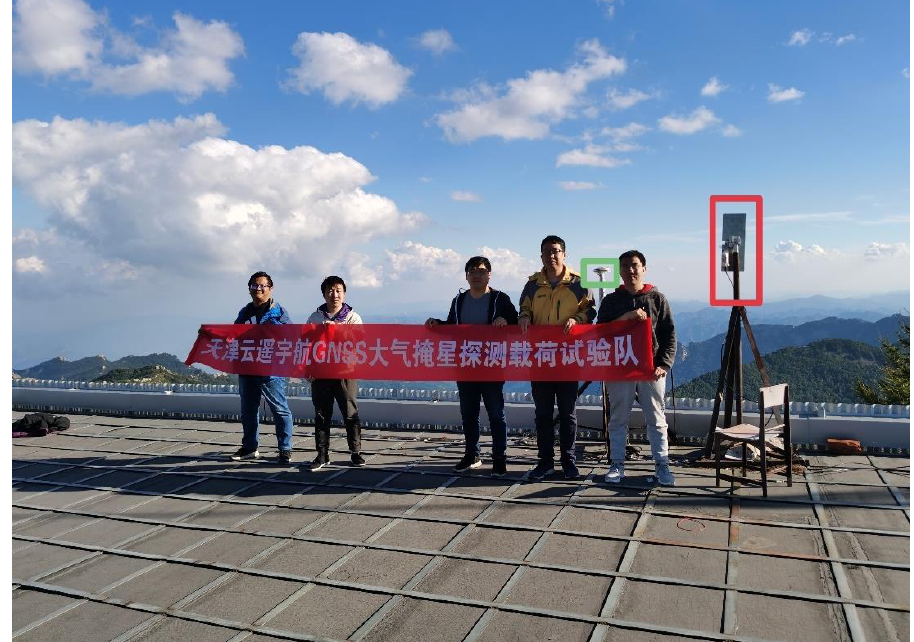
Figure 3. Mountain-based location, behind our experiment team is the bottom of the mountain. Our occultation antenna (the part marked in red in the picture) is mounted on a tripod and placed facing south, and our positioning antenna (the part marked in green in the picture) is also installed on the tripod. On the tripod, place it towards the zenith. The south side of the mountain is empty, which is conducive to our experiments.